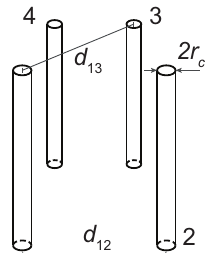
Figure 8. System of four parallel vertical conductors approximating the main legs of the truss tower under